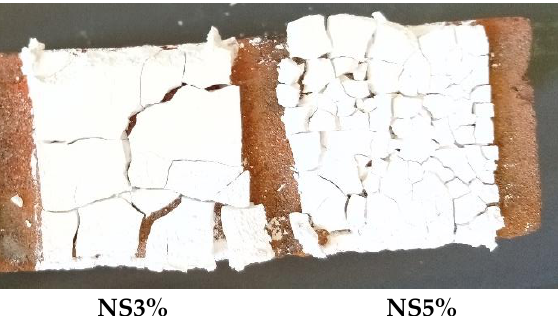
Figure 6. Cracking in lime paste applied on porous brick due to the effect of nanosilica.